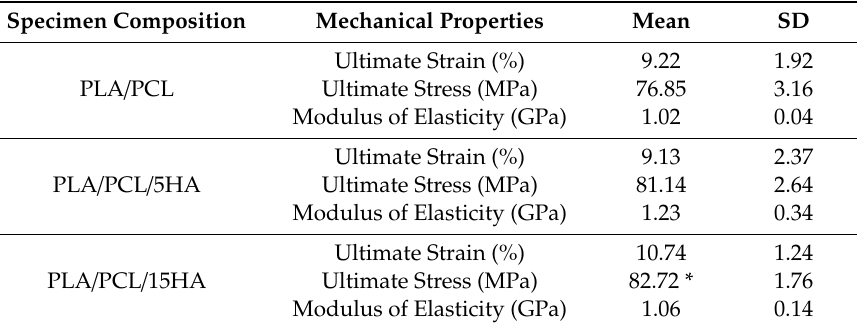
Table 5. Summary of compression